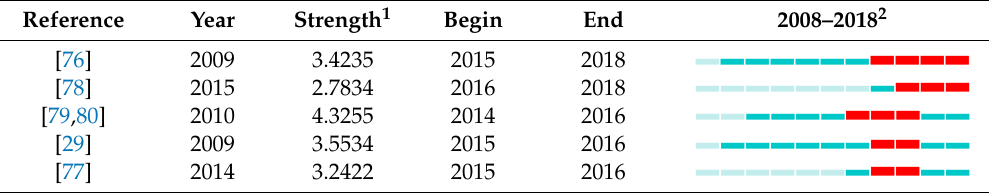
Table 5. Main information of explosively cited papers sorted by year of termination.